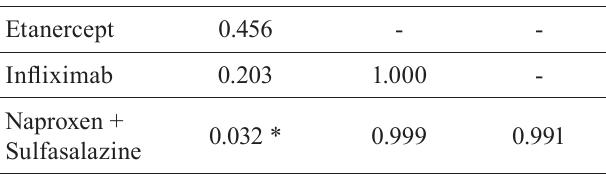
TABLE IV – Results of the Nemenyi’s test (p-values) after comparison between the averages of ASQoL between each